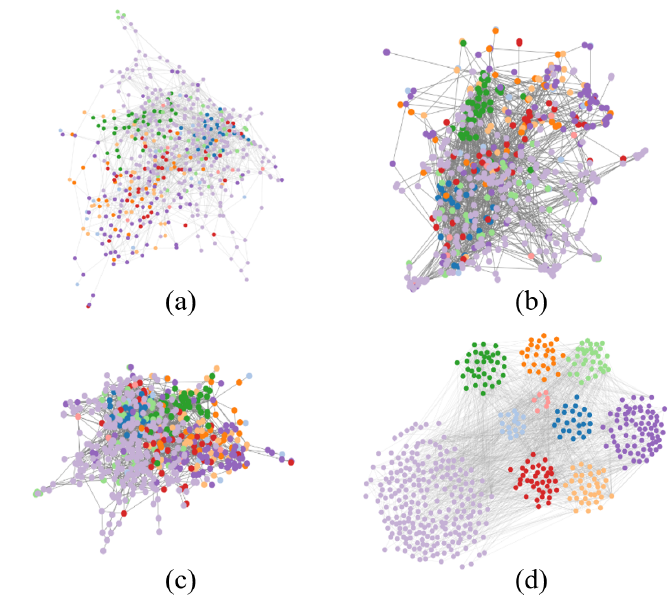
Figure 4. The result of attribute community layout under the attribute ‘keywords’. ( a ) FR layout;